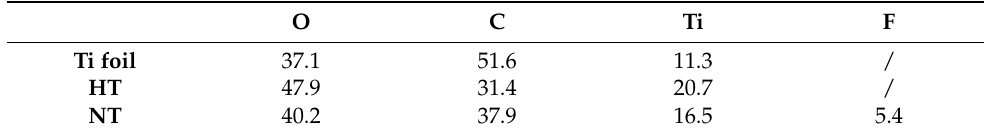
Table 1. Atomic concentration ( % ) of detected elements by XPS on: Ti foil, hydrothermally treated Ti foil (HT), and TiO 2 nanotubular (NT) surface (diameter of the nanotubes = 100 nm). O